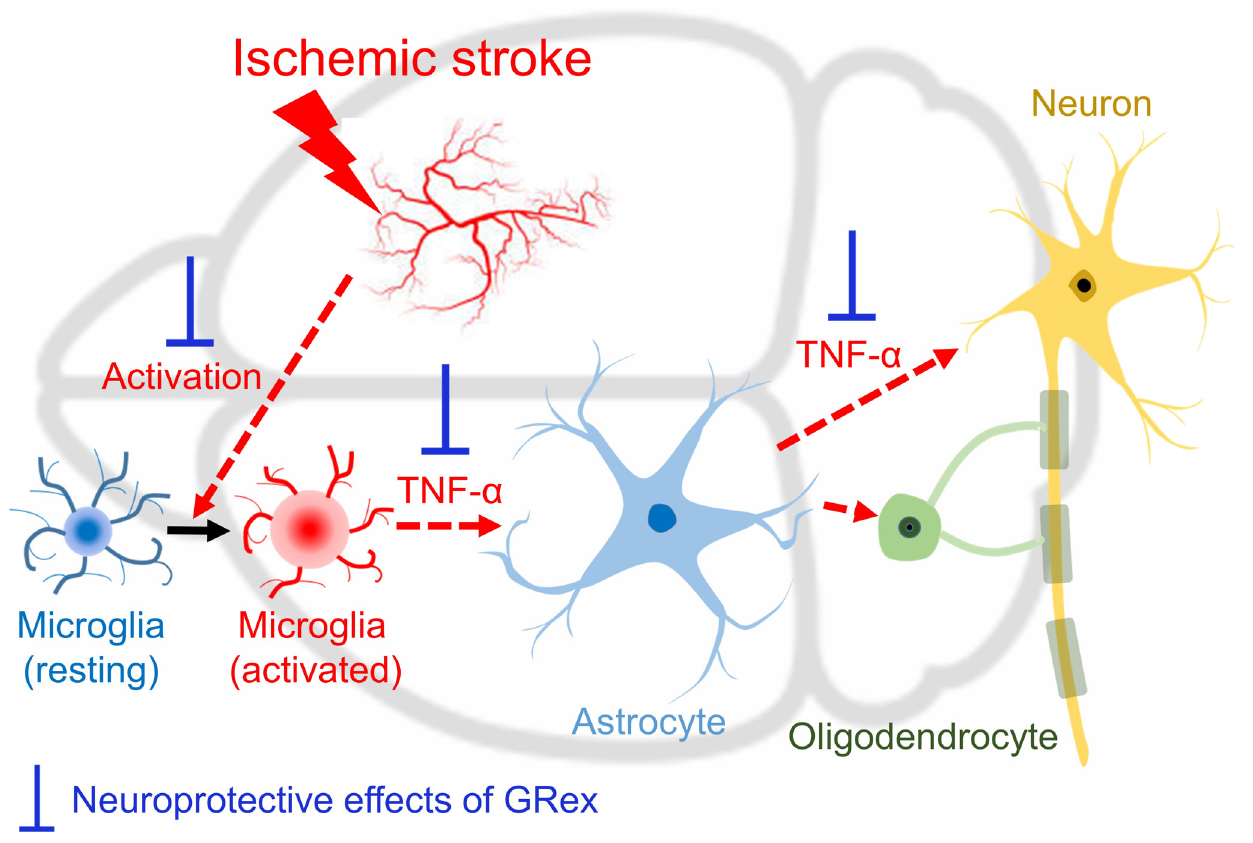
Figure 7. Schematic image of the anti-inflammatory action mechanism of GRex in MCAO mice model. Thickened brown bars indicate the predicted action site of GRex post-treatment on ischemia/reperfusion-induced brain damage.